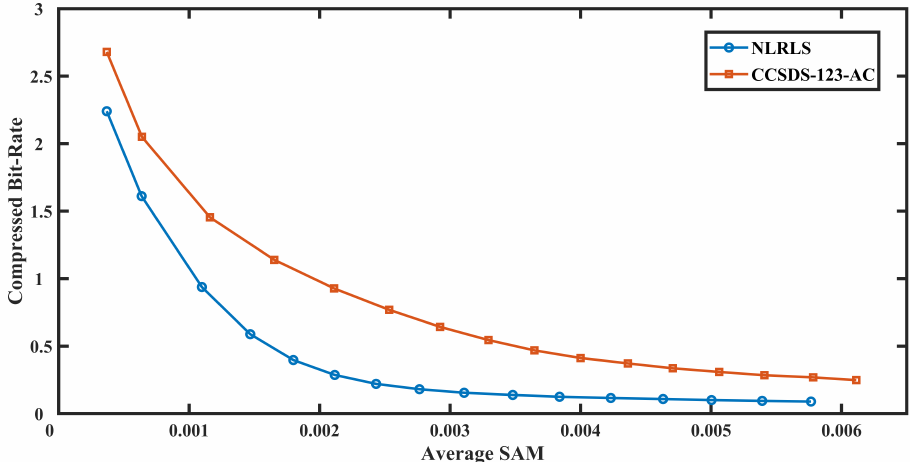
Figure 7. The SAM performance of the proposed method compared to